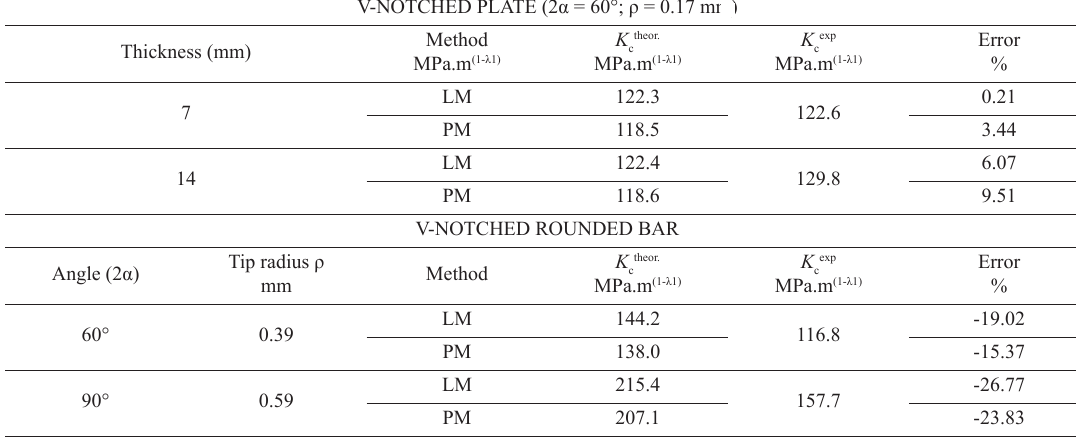
Table 9. Assessing V-notched specimen